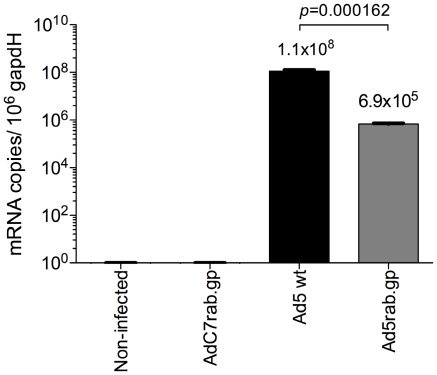
AdHu5 hexon quantitative real-time PCR.RNA isolated from non-infected cells (dashed bar) and from cells infected with AdC7rab.gp (white bar), Ad5 wt (black bar) or Ad5rab.gp (gray bar) were reverse transcribed and normalized to equal amount of gapdH mRNA copies. Ad5 hexon mRNA copies were quantified by real-time PCR using specific primers. No Ad5 hexon specific mRNA was detected in non-infected cells or cells infected with AdC7rab.gp. Ad5 hexon mRNA levels were assessed in triplicates. Averages (Ad5 wt and Ad5rab.gp) and p values from two-tail student's t test are shown on top of the bars.